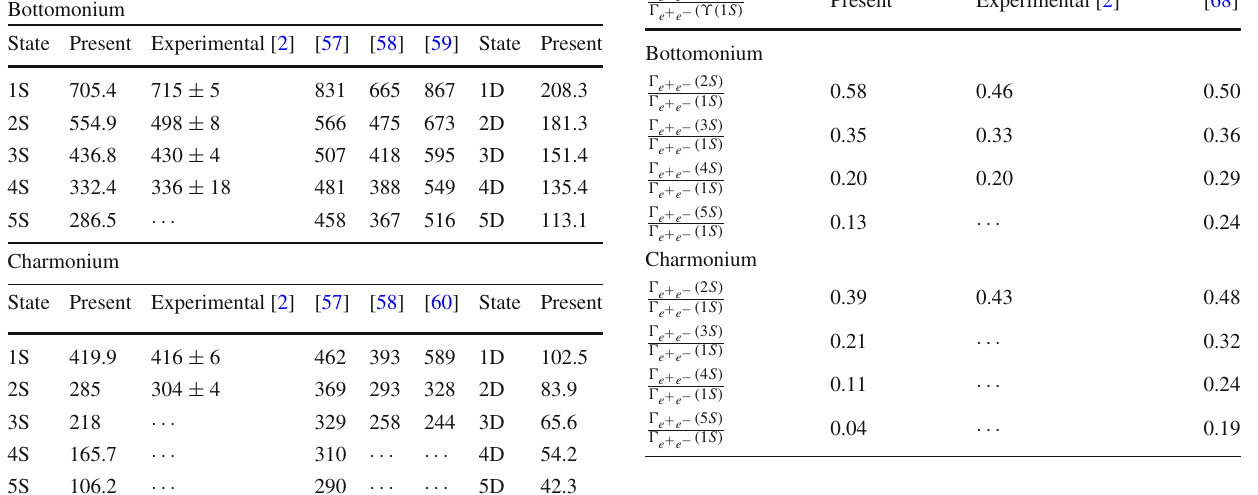
Table 8 Vector decay constant ( F v in MeV) of the S-wave and D-wave bottomonium and charmonium states Bottomonium